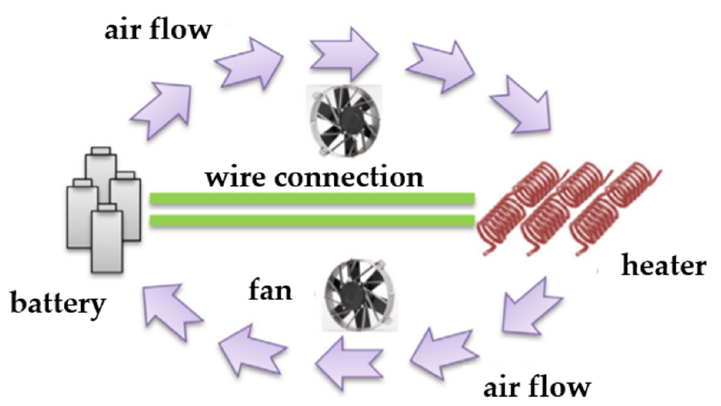
Figure 7. Schematic diagram of the convection heating system [50]. Reproduced from reference [50] with permission from Elsevier B.V., copyright 2013.